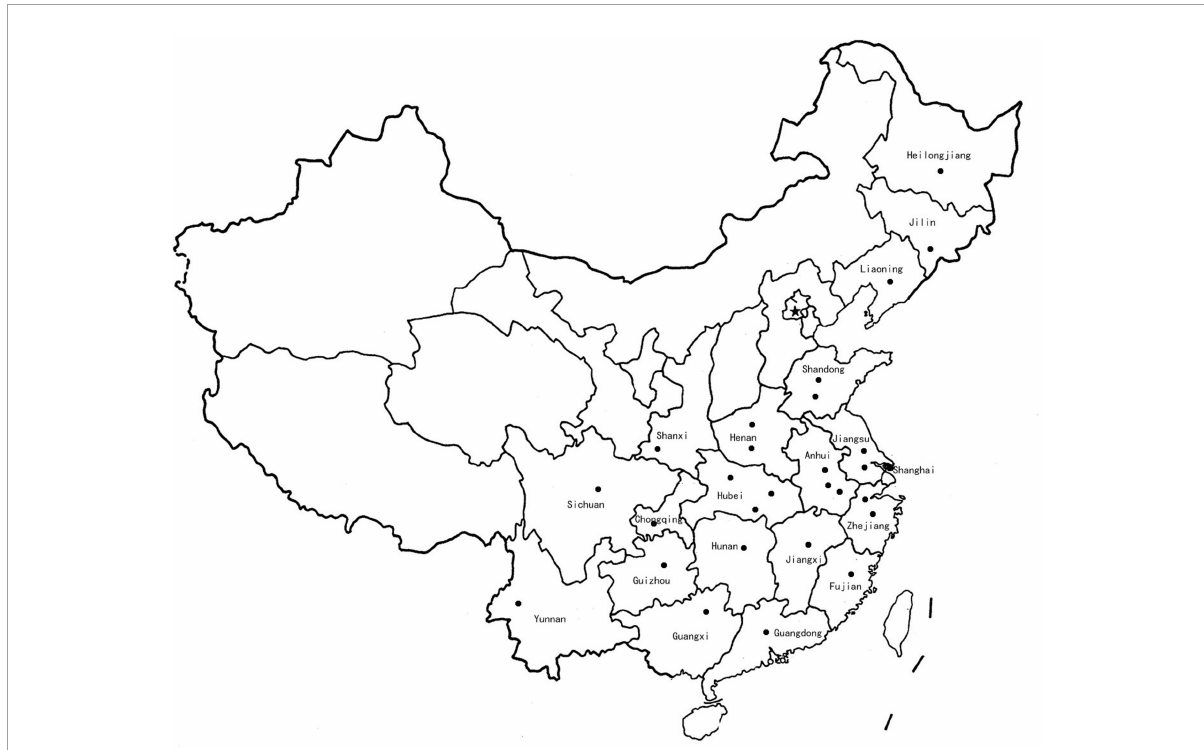
FIGURE1 Map of China showing the location (dots) where Fusarium proliferatum strains were collected.